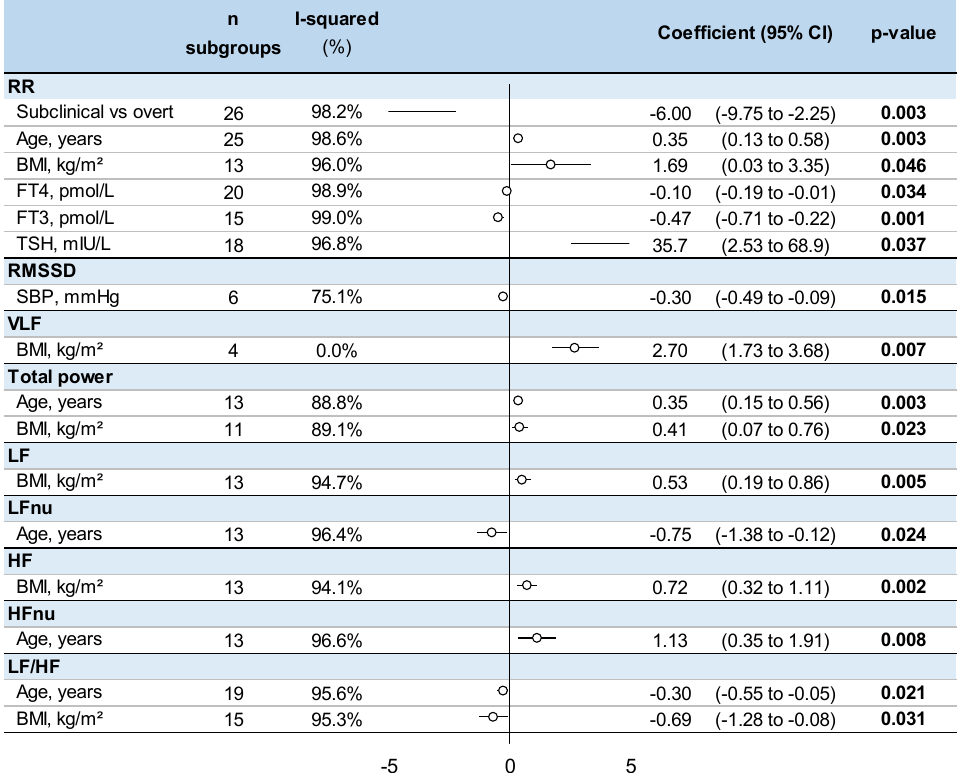
Figure 3. Meta-regressions of significant factors influencing heart rate variability in untreated hy- perthyroid patients (exhaustive meta-regressions are presented in Figure S5). RR: RR intervals (or normal-to-normal intervals—NNs), BMI: body mass index, FT4: free thyroxine, FT3: free triiodothy- ronine, TSH: thyroid-stimulating hormone, RMSSD: the square root of the mean squared difference of successive RR intervals, SBP: systolic blood pressure, VLF: very low frequency, LF: low frequency, LFnu: low frequency-normalized units, HF: high frequency, HFnu: high frequency-normalized units, LF/HF ratio: low frequency/high frequency ratio.